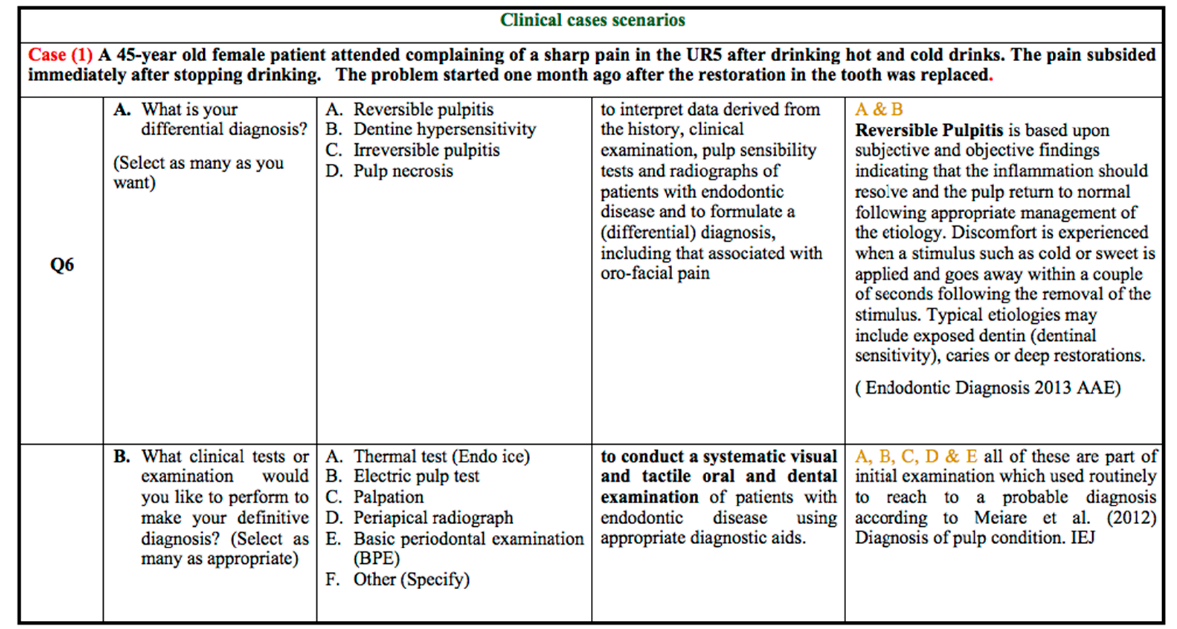
Figure 1. Clinical case scenario 1.[7]